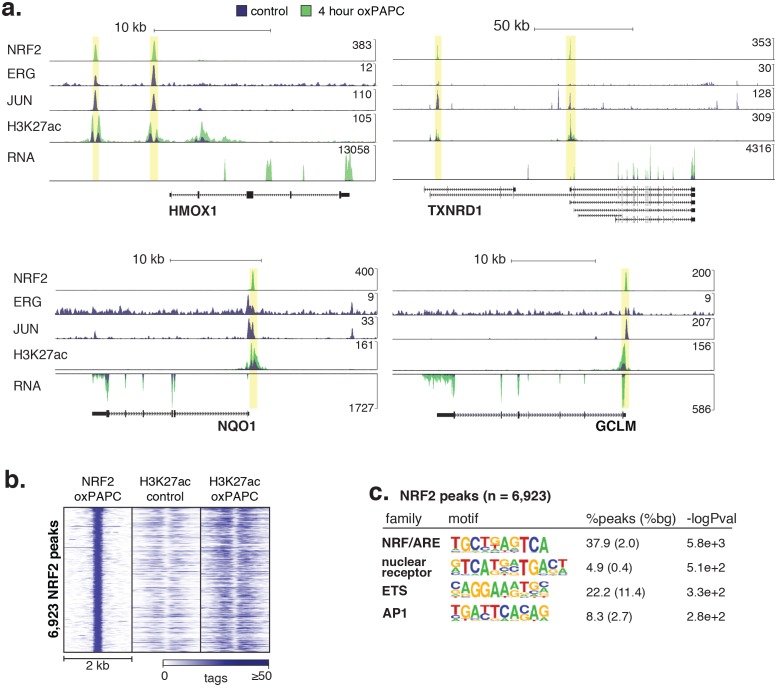
Signal-responsive transcription factor NRF2 binds endothelial enhancers.(a) HMOX1, TXNRD1, NQO1, and GCLM loci are co-bound by ERG, JUN and NRF2 and acquire H3K27ac upon oxPAPC treatment. (b) NRF2 binding was measured by ChIP-seq after oxPAPC treatment and coincides with increased H3K27ac on adjacent nucleosomes. (c) The top most enriched motifs at NRF2 peaks. (d) NF-κB component p65 ChIP-seq identified 36,363 distal loci that largely gained H3K27ac upon TNFα treatment. (e–f) Top enriched motifs at distal TNFα-induced (e) and IL1β-induced (f) p65-bound loci.